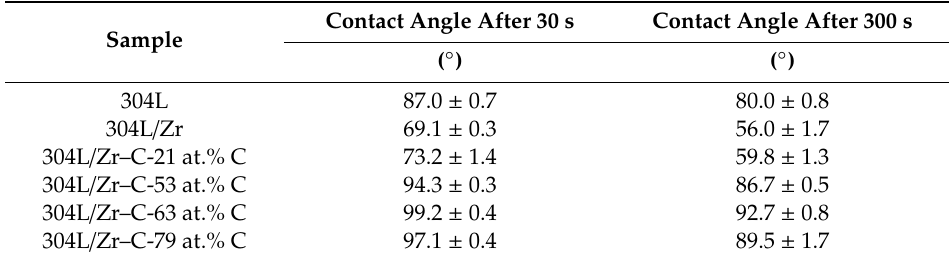
Table 5. Contact angle of 304L steel substrate, bare and coated with Zr–C, with Fusayama-Meyer’s artificial saliva.